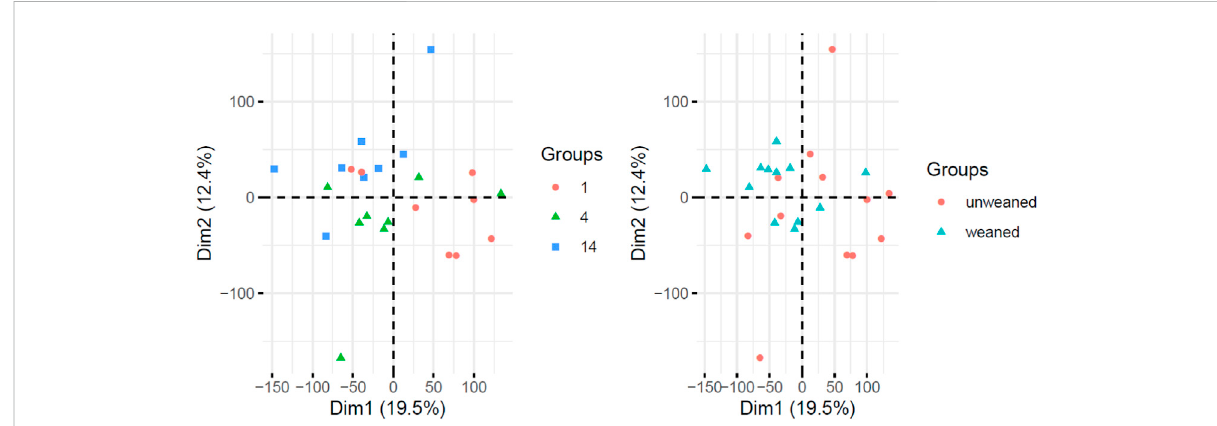
FIGURE 4 Principal Component Analysis (PCA) of gene expression data from pigs labelled as time point (left panel) and weaning status (right panel).